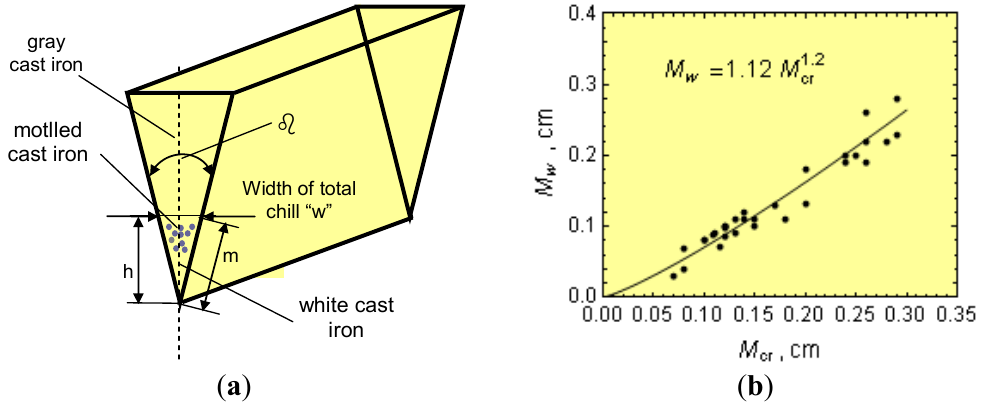
Figure 4. ( a ) Wedge geometry and ( b ) relationship between the casting modulus of the wedge with the critical casting